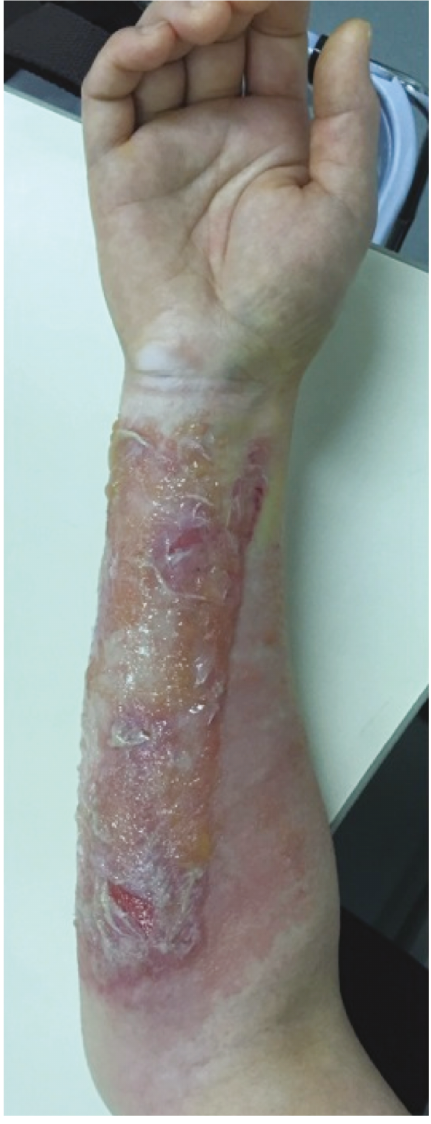
Figure 1: The forearm skin state on her visit to our hospital. Skin disorder accompanied by blister formation was observed on the right forearm. The blistering was present along the splint application